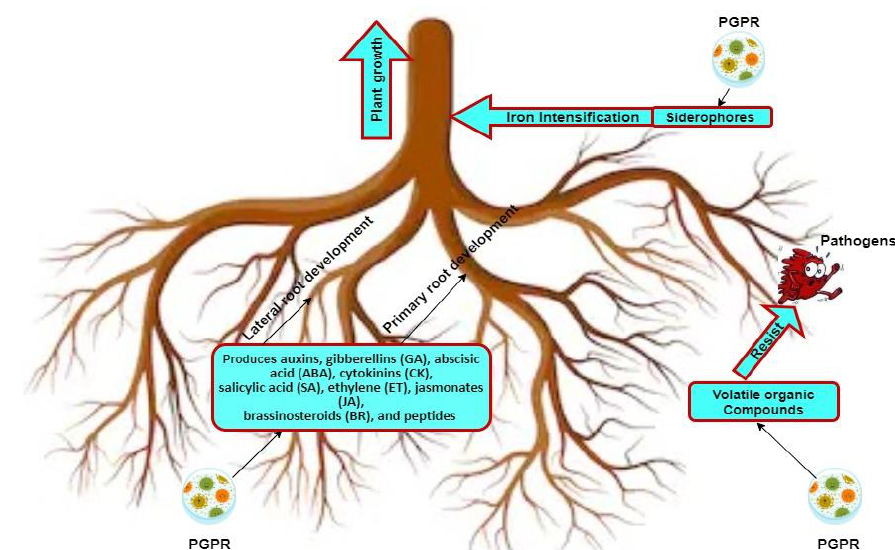
Fig. 2 : Mechanism of PGPR in plant growth Fig. 2: Mechanism of PGPR in plant growth regulating